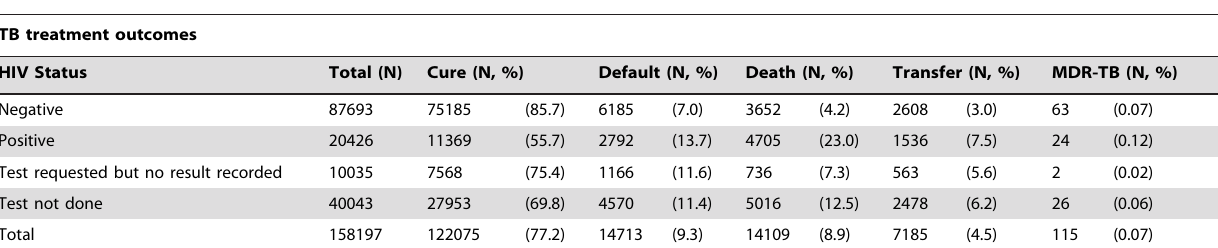
Table 2. TB treatment outcomes by HIV status in new TB cases diagnosed in 6 States of Brazil between 2003 and 2008.